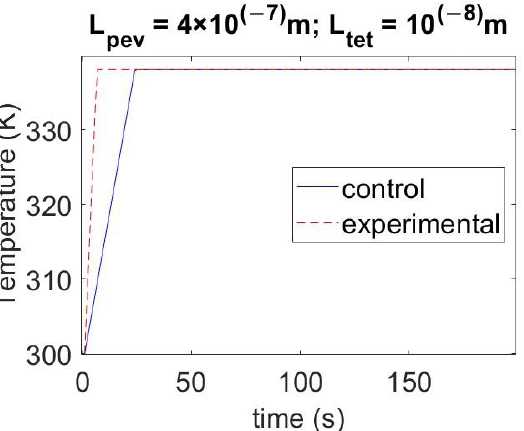
Figure 8. The control and experimental temperature of the perovskite layer in the case of a thin tetracene layer.